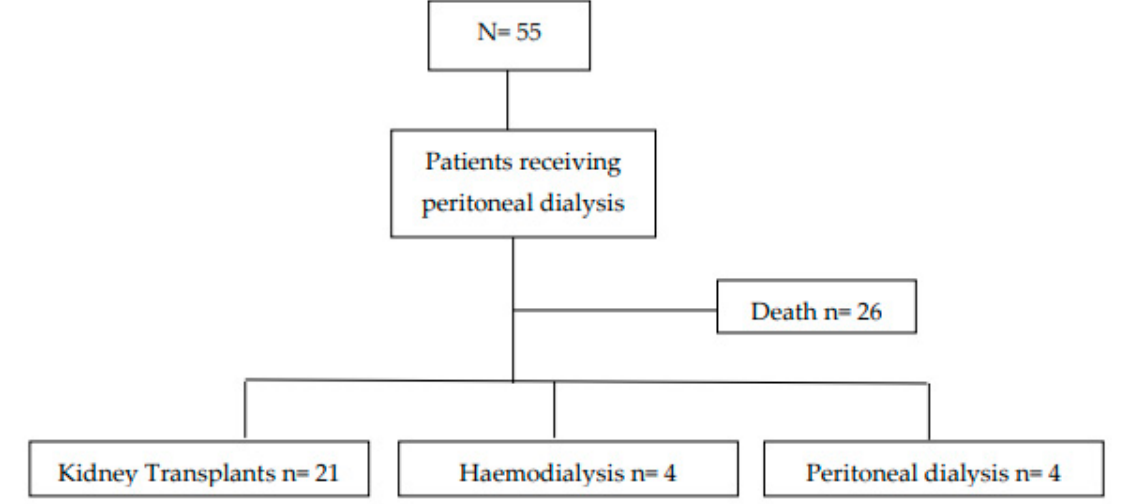
Figure 1. Evolution of patients and treatment used.